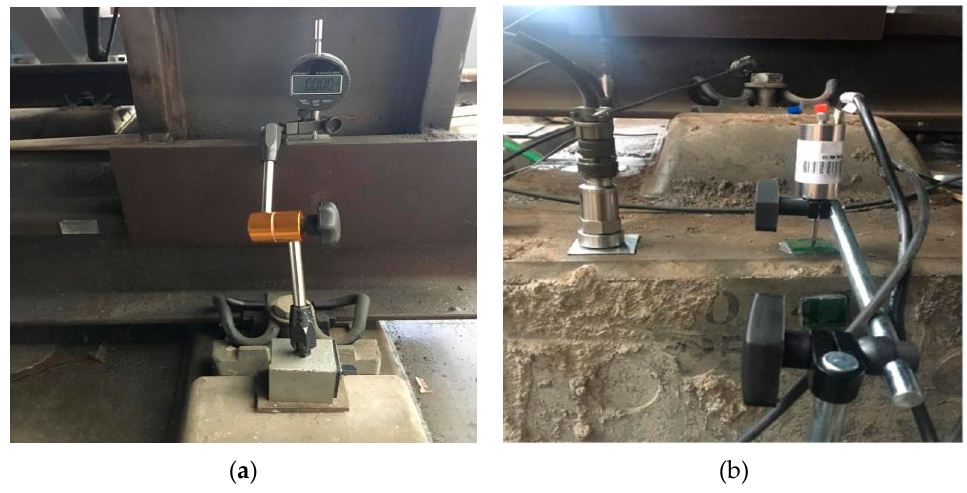
Figure 6. Test components: ( a ) dial indicator; ( b ) accelerometer ( left ) and displacement sensor ( right ).